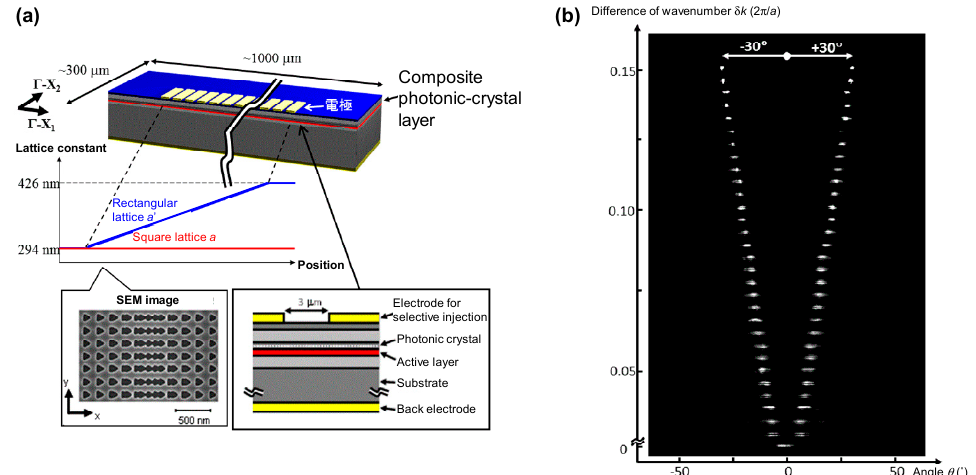
Figure 7. ( a ) Schematic of a device with composite photonic-crystal structures for 1D beam steering. ( b ) Demonstration of 1D beam steering. Reprinted by permission from Springer Nature, Nature Photonics [10], 2010.